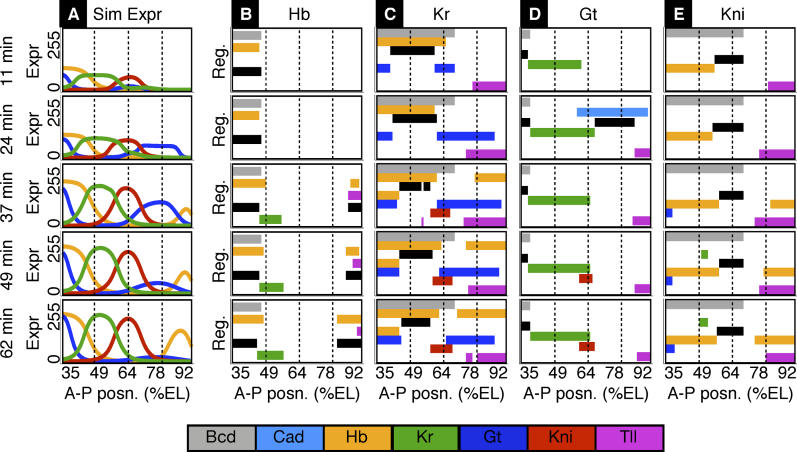
Simulated Gap Gene Expression, Production, and Regulatory Effects in the RPJ-Logic Model